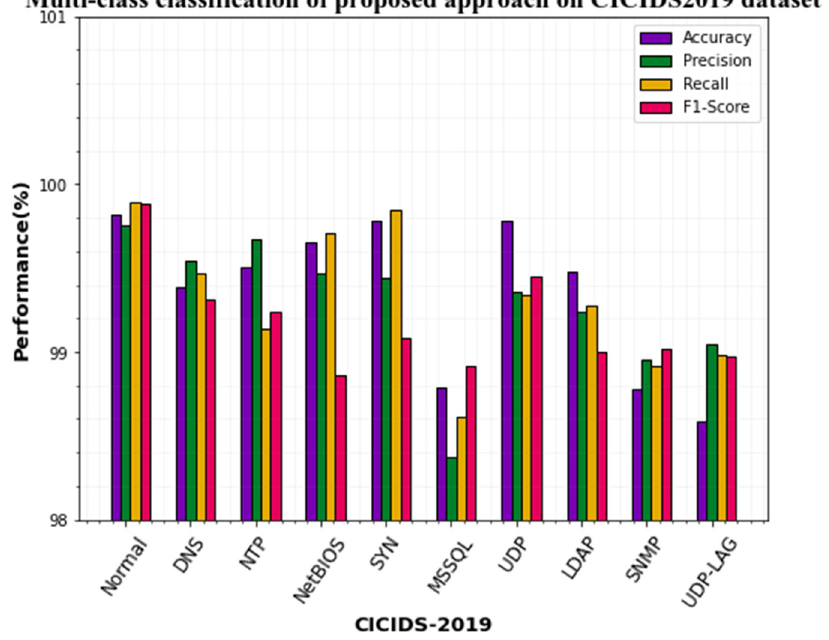
Figure 7. Multiclass classification performances on CICIDS-2019 dataset.